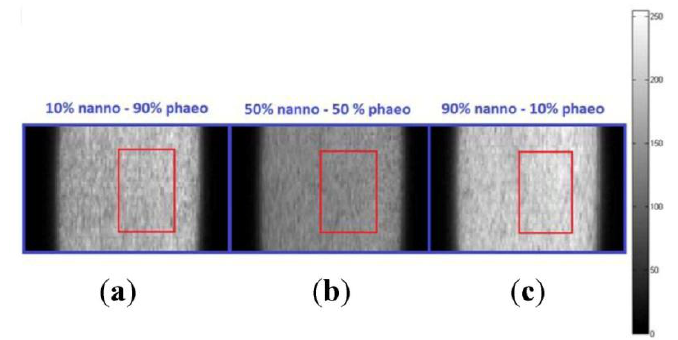
Figure 2. 8-bit scaled image frames at 600 nm for three algae mixtures: ( a ) 10% nanno–90% phaeo; ( b ) 50% nanno–50% phaeo; ( c ) 90% nanno–10% phaeo. Red rectangles show the region of interest (frame pixels (samples and lines) to be averaged to obtain a single spectrum representing each mixture). (nanno: Nannochloropsis salina ; phaeo: Phaeodactylum tricornutum